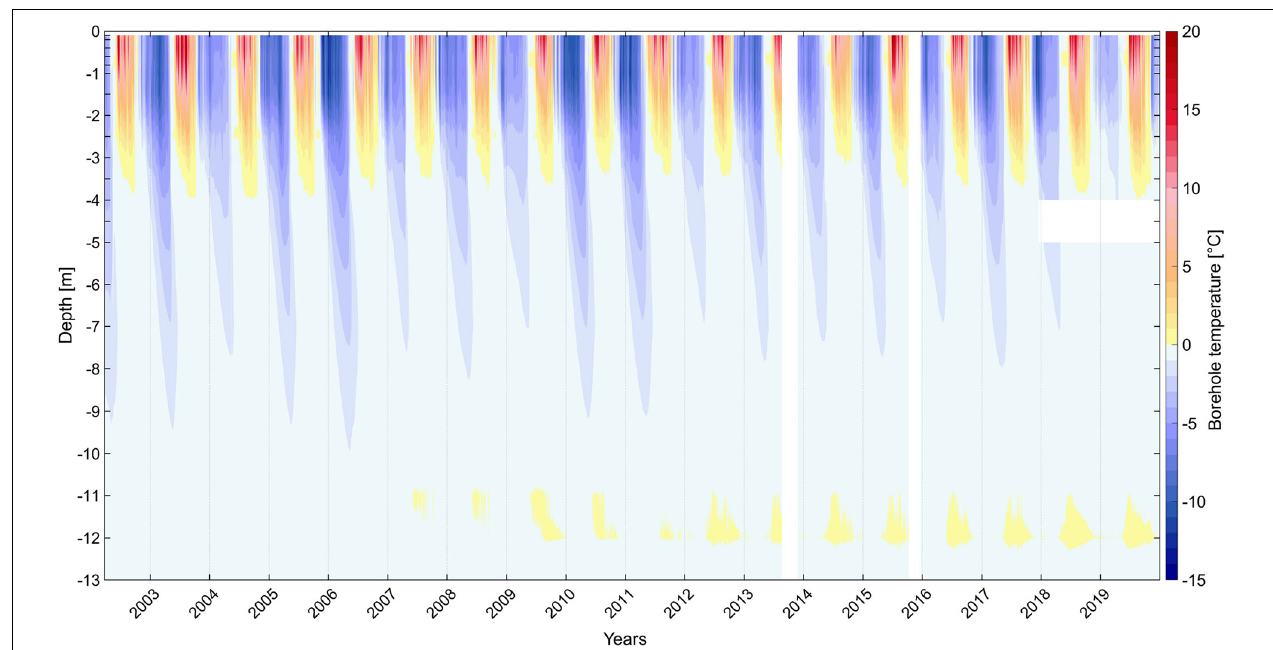
FIGURE 12 | Contour plot of borehole temperatures in Ritigraben rock glacier (2002–2019). The talik is located at 11–12 m depth and started in 2007. The seasonal freezing (bluish colours) and thawing (reddish colours) periods (active layer thickness) at this ice-rich site are also shown. Gaps (white areas) are due to logger or battery